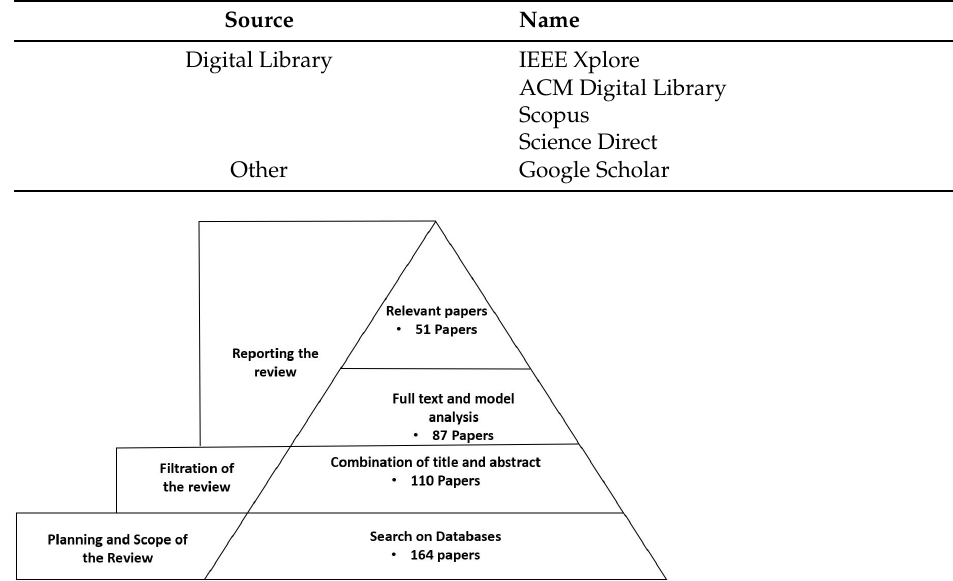
Figure 3. An illustration of the methodology adopted for conducting the